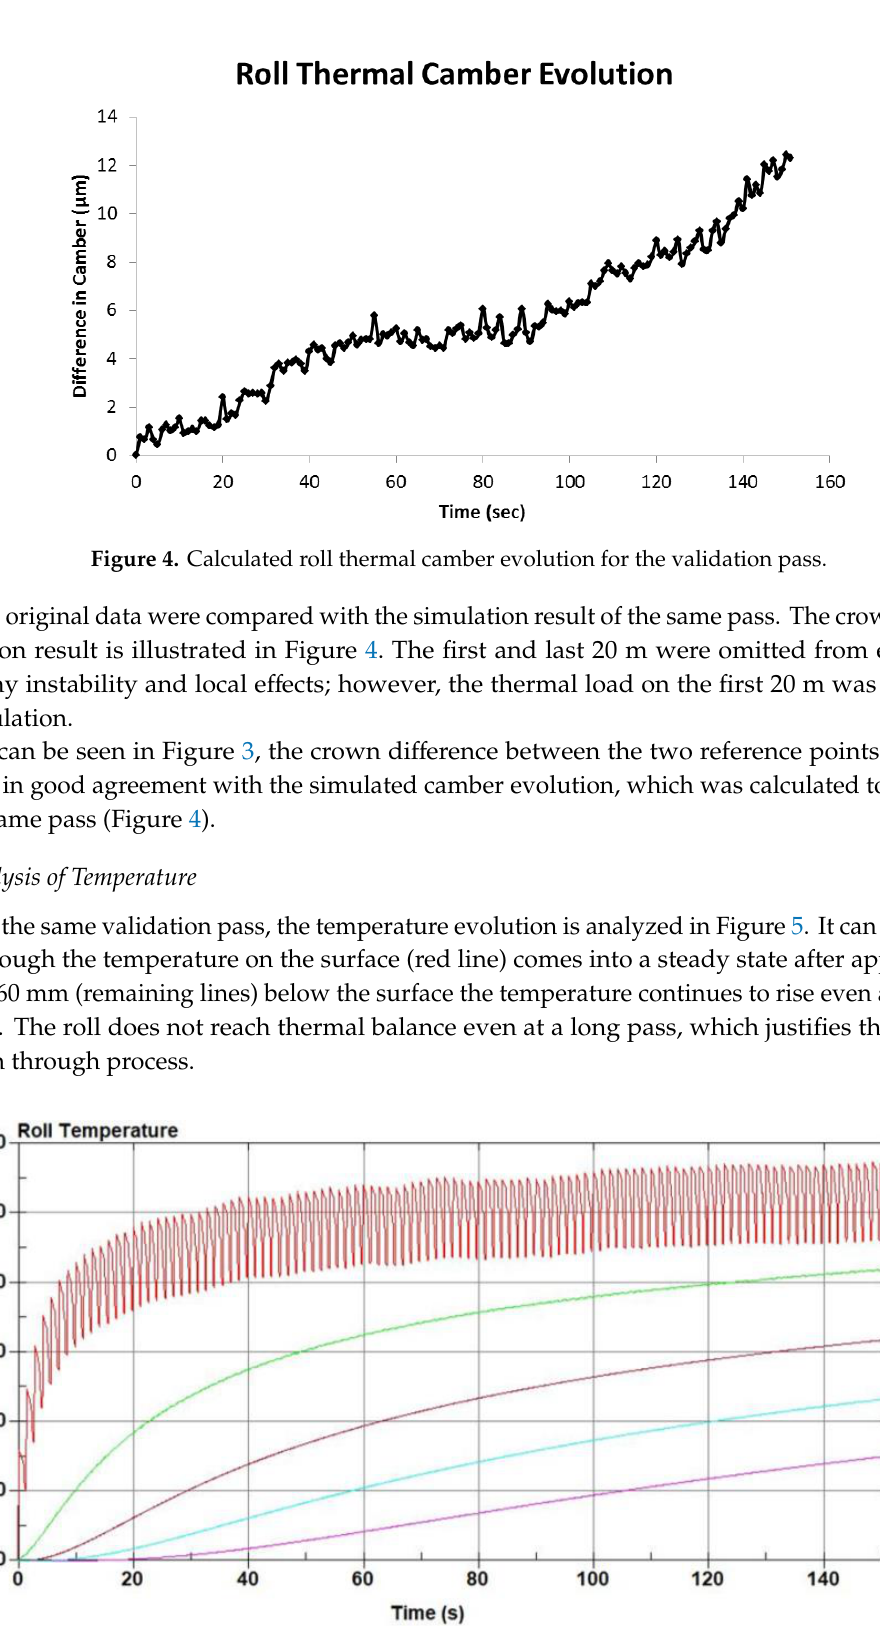
Figure 5. Temperature evolution across the roll surface.